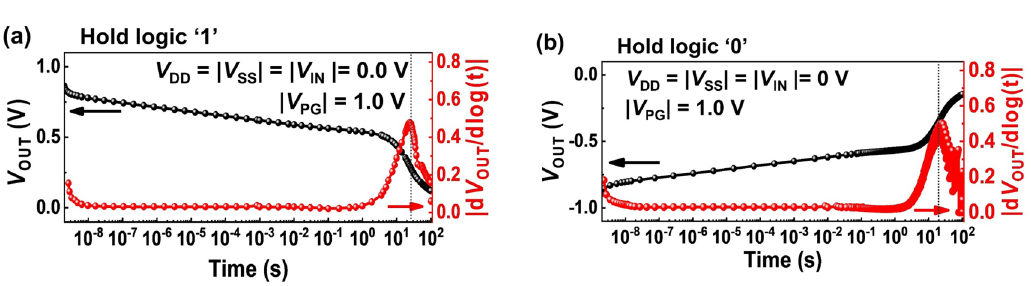
Figure 5. V OUT and |d V OUT /dlog(t)| for holding the output logic ( a ) ‘1’ and ( b ) ‘0’ states. The time to reach maximum |d V OUT /dlog(t)| represents the retention